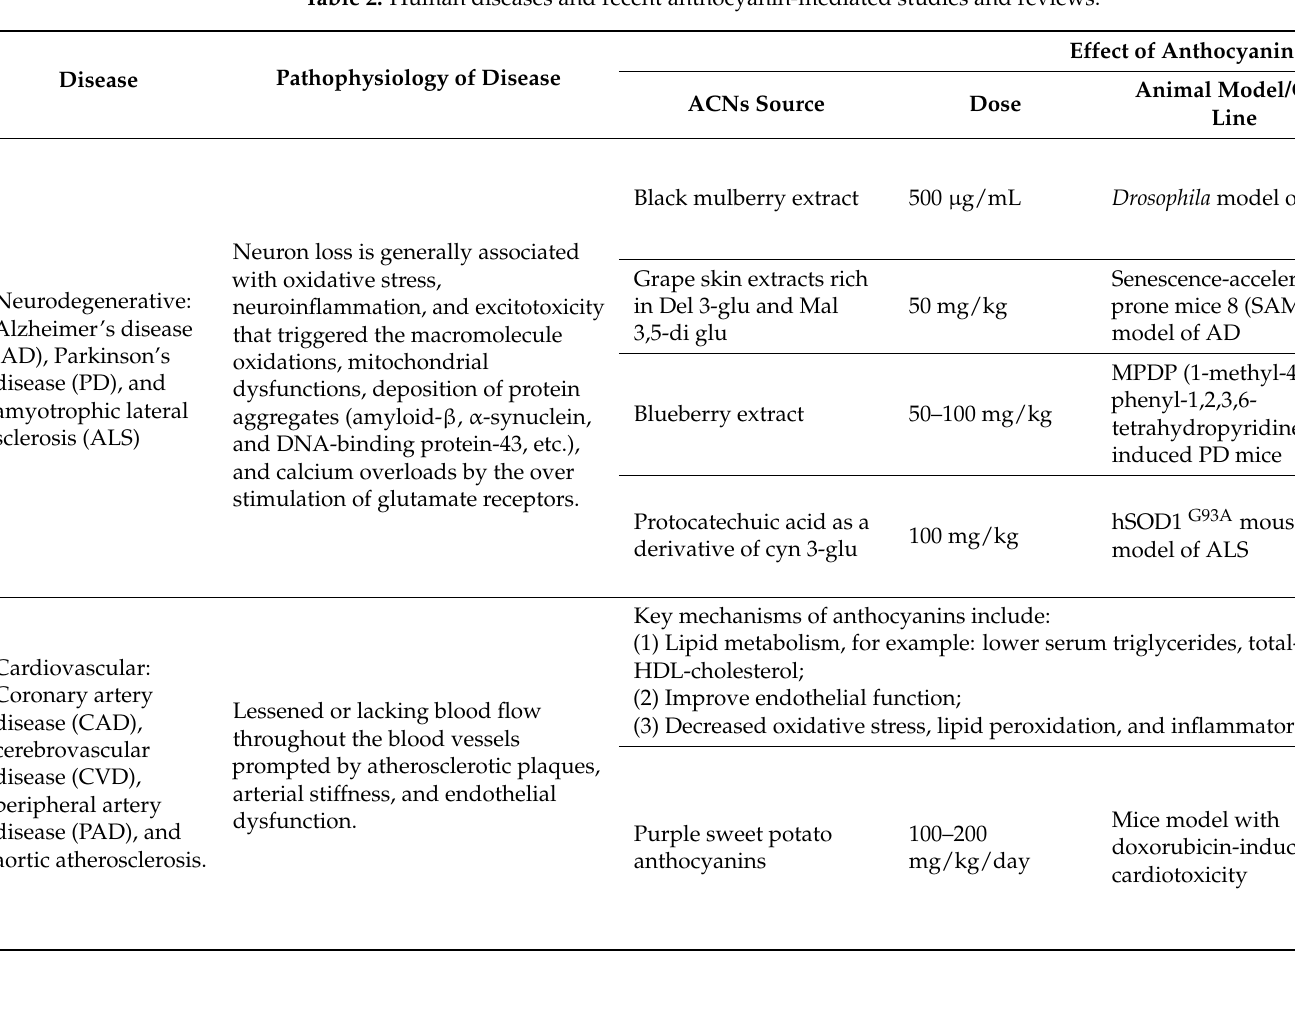
Table 2. Human diseases and recent anthocyanin-mediated studies and reviews.